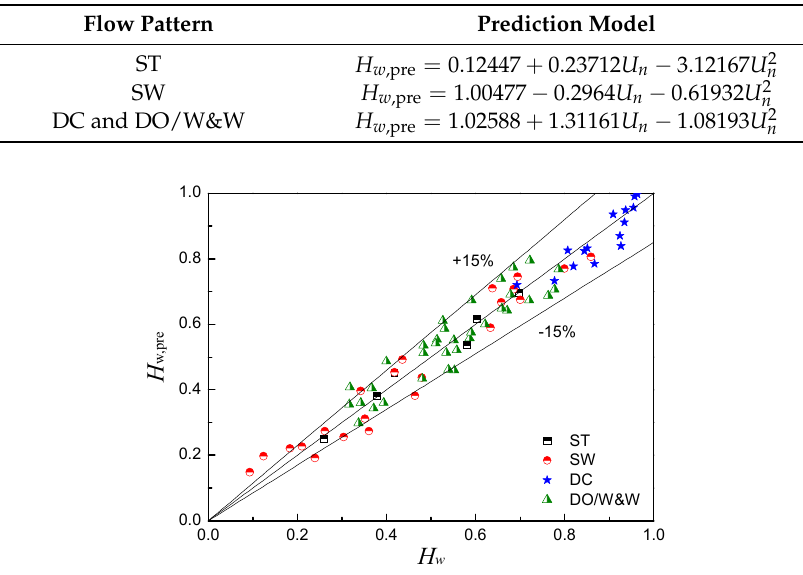
Figure 16. Prediction results of the water holdup using the phase shift detection technology.